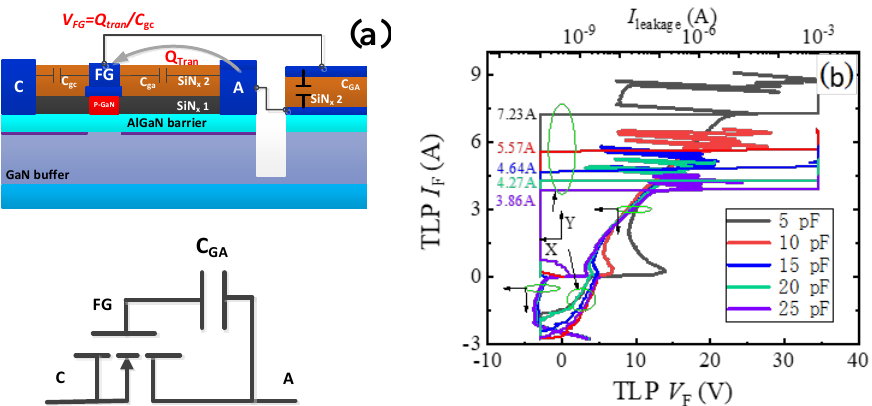
Figure 8. The schematic structure, equivalent circuit ( a ) and bidirectional TLP I–V characteristics ( b ) of the unidirectional AlGaN/GaN ESD protection diode.